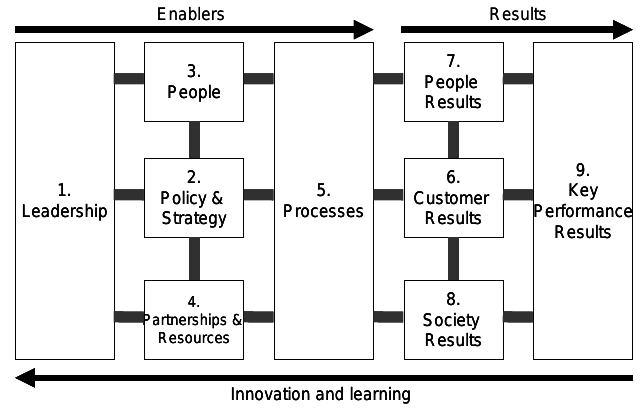
Figure 1. “Model EFQM (European Foundation for Quality